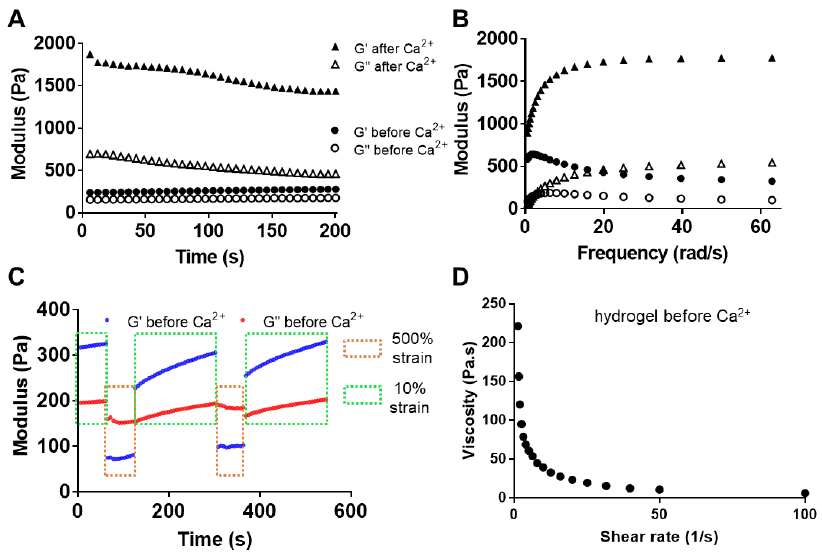
Figure 2. Rheological properties of dynamic alginate hydrogel. ( A ) Time-sweep studies indicating storage modulus (G’) and loss modulus (G’’) change in dynamic hydrogels before and after CaCl 2 crosslinking. ( B ) Frequency- sweep studies indicating G’/G’’ of the dynamic Alg -PBA- PVA hydrogel before and after CaCl 2 crosslinking. ( C ) Recovery of G’ and G’’ of dynamic Alg -PBA- PVA hydrogel under alternate step strains of 10% (180 s) and 500% (60 s) for two consecutive cycles (blue line: storage modulus, red line : loss modulus) ; ( D ) Viscosity of the dynamic hydrogel with increased shear rate from 1 s −1 to 100 s −1 .